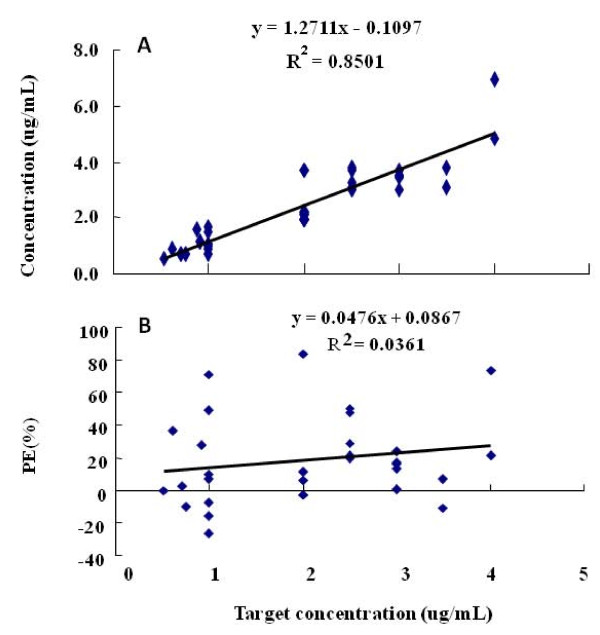
Predicted concentrations of Propofol in 1<year< 3 by SLOG TCI-III(Pediatric)system (Figure 2A), and performance error (PE%) against the calculated concentrations in 1<year< 3 by SLOG TCI-III (Pediatric) system (Figure 2B).